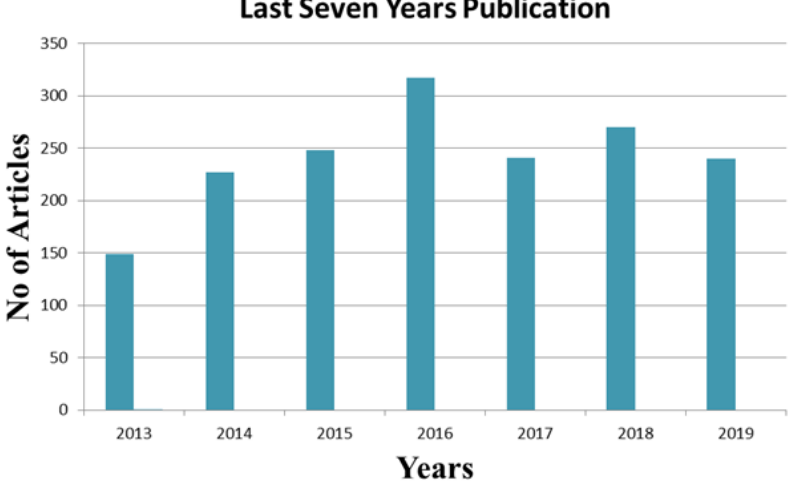
Figure 1. The number of articles on intellectual disability published in the last seven years identified using the PubMed search terms “ID”, “mental retardation”, “next-generation sequencing”, and “exome